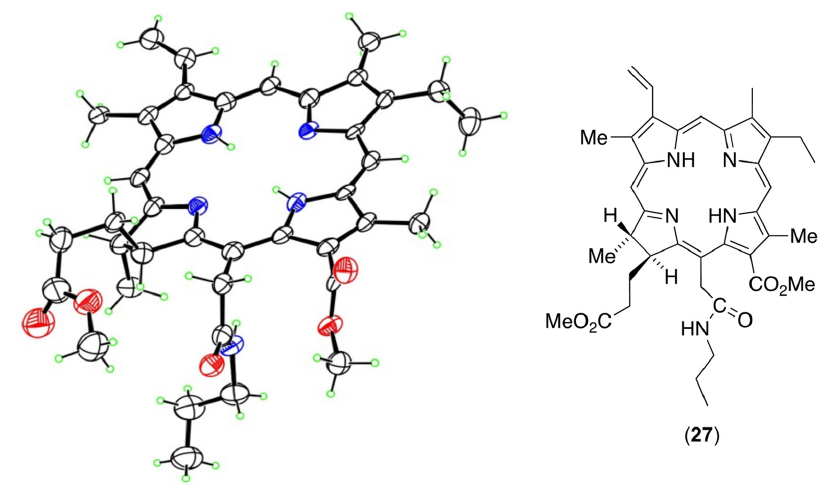
Figure 8. X-ray structure of 15 2 -propylamide ( 27 ).